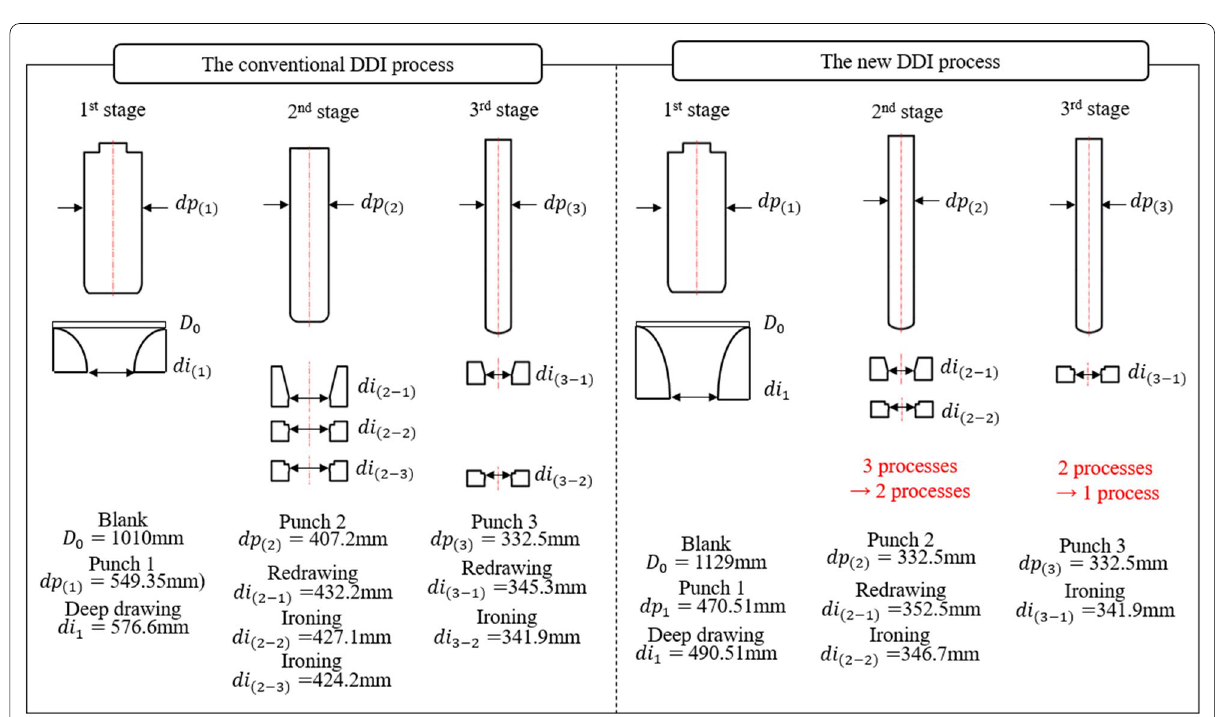
Figure 19 Comparison of the new DDI process with the existing